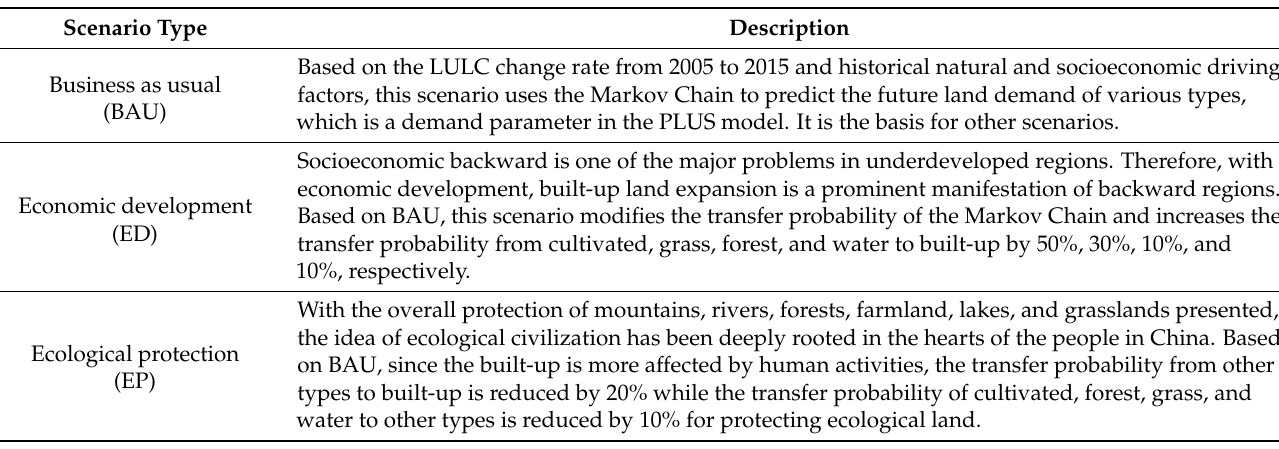
Table 2. Scenario setting based on the PLUS